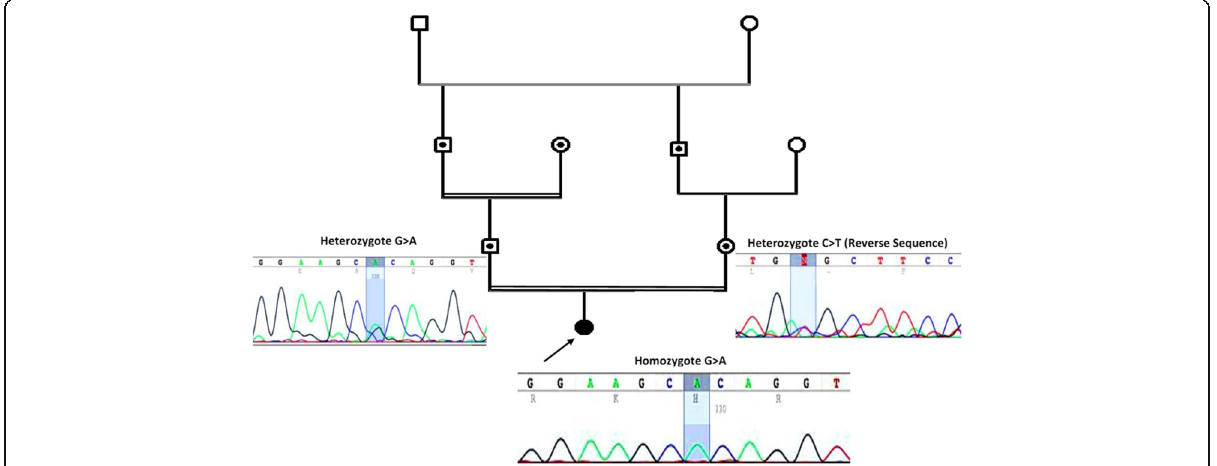
Fig. 3 Pedigree and sanger sequencing details of Family I. Using Sanger sequencing, the inheritance mode of autosomal recessive was confirmed in this family based on identified heterozygote mutation in parents and homozygote in the proband. Sanger sequencing was performed on other patients, parents and their extended family members (data not